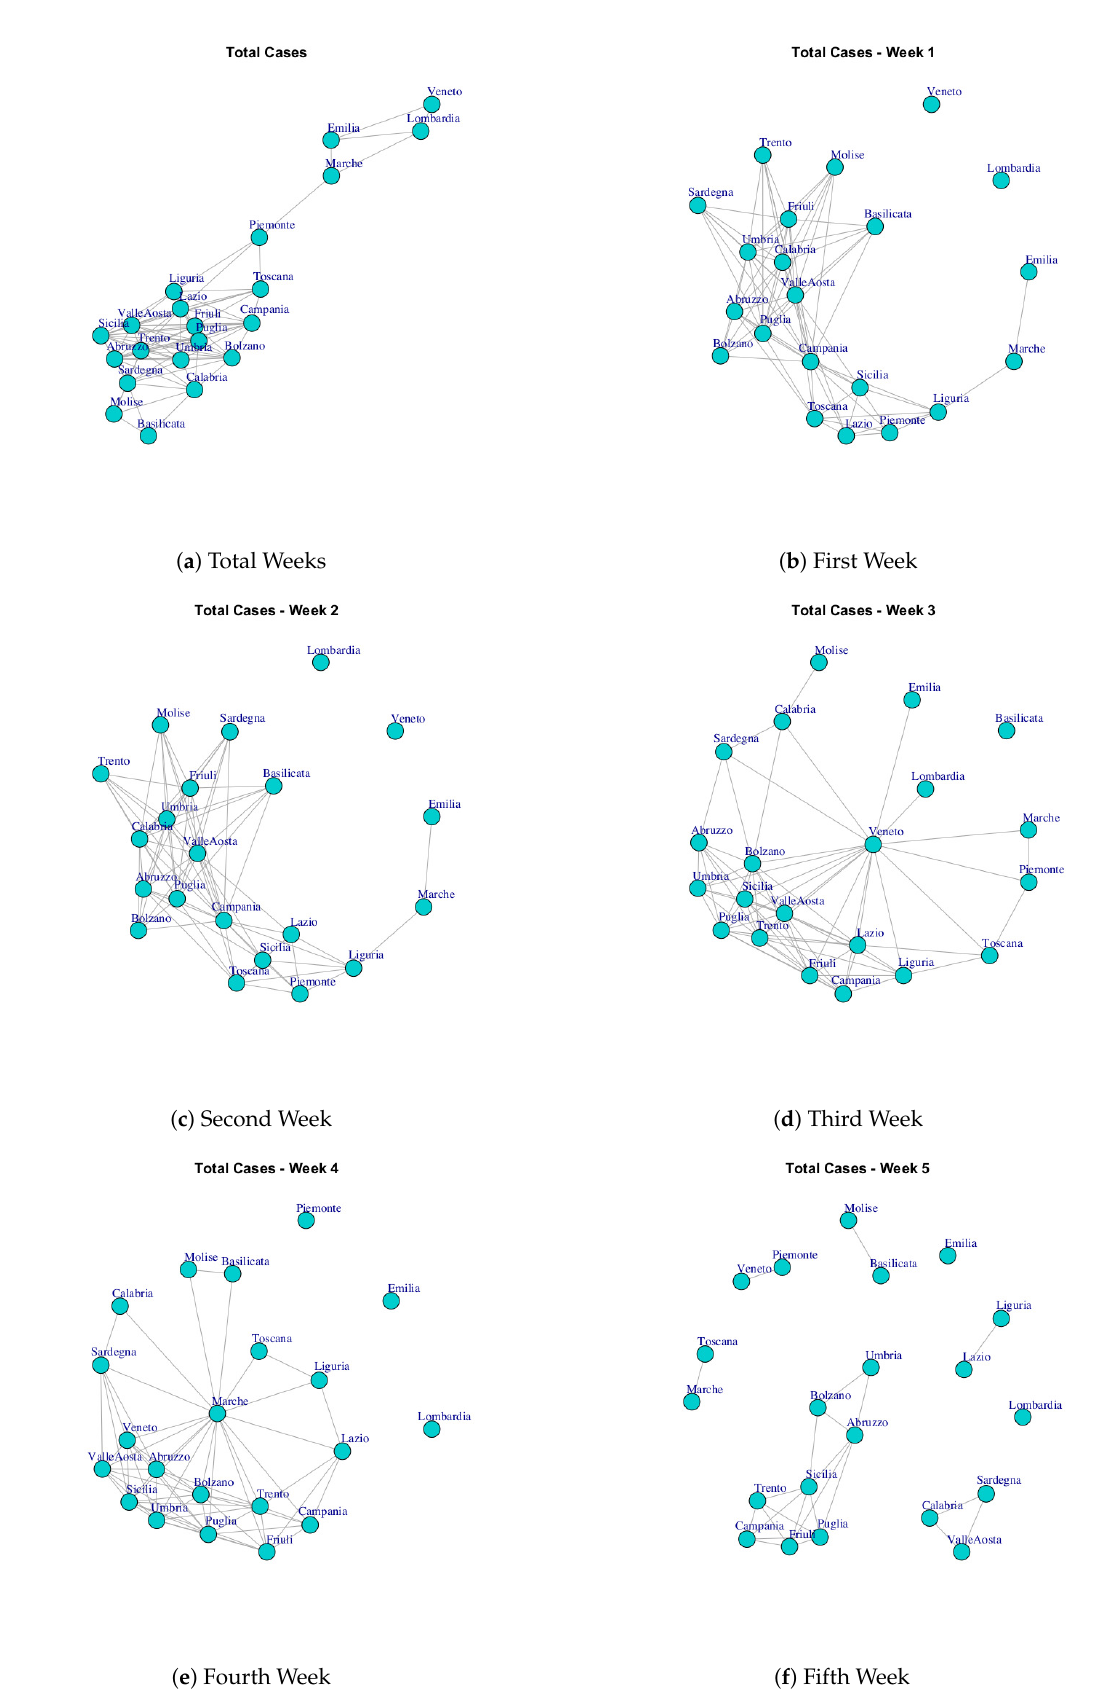
Figure 11. Evolution of Total Cases